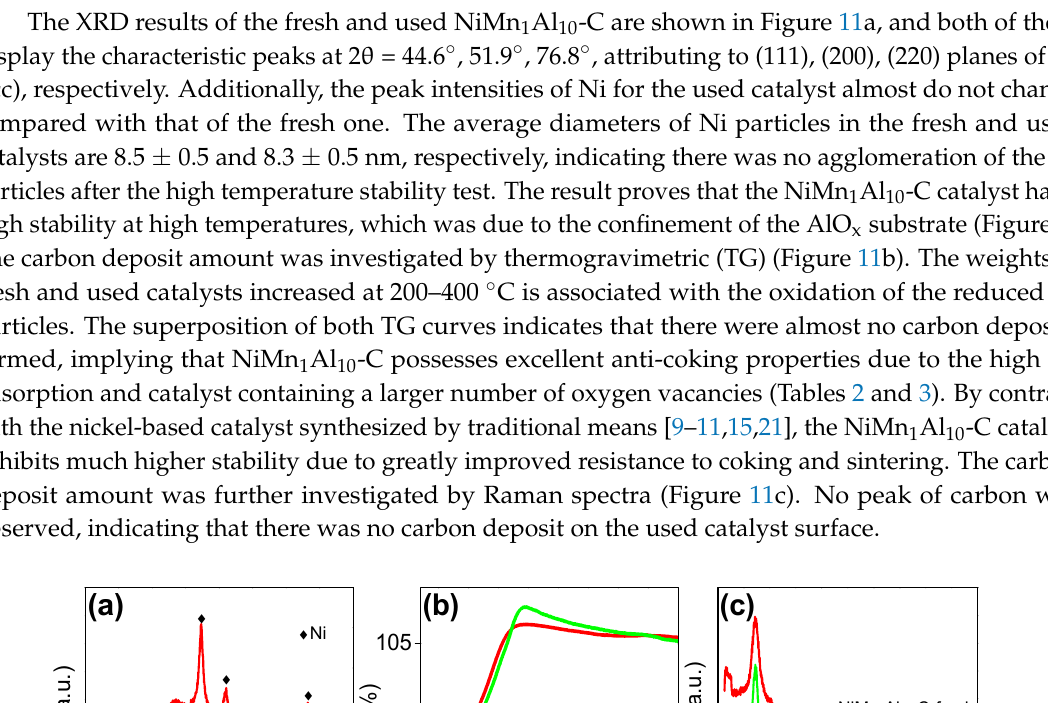
Figure 10. Low temperature ( a ) and high temperature ( b ) lifetime tests of the catalysts.